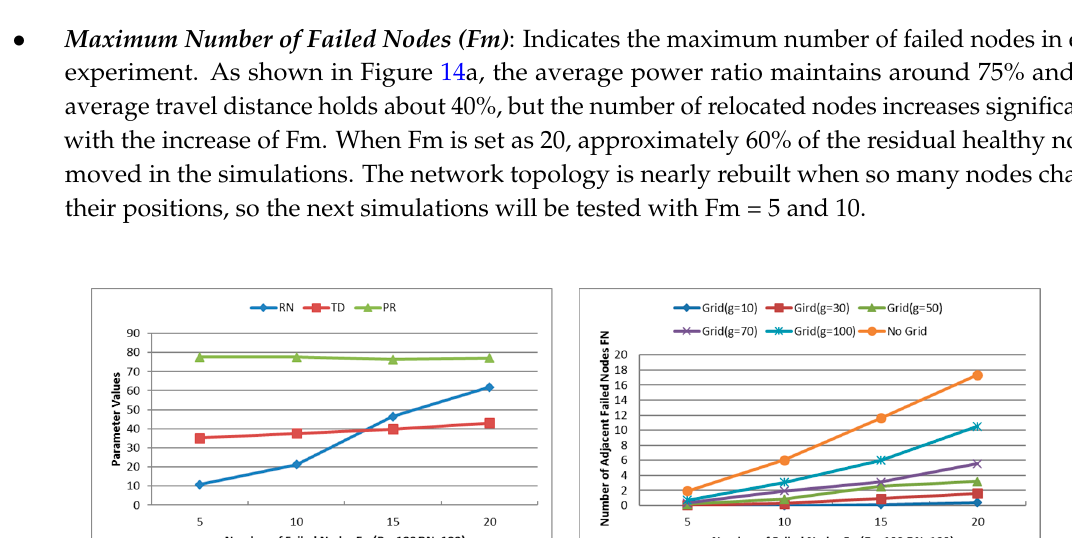
( b ) Figure 15. ( a ) FN with different (cid:1844) (cid:3030) and Fm; and ( b ) FN with different DN and Fm. Figure 15a indicates that the number of adjacent failed nodes increases significantly without gridding in both cases (i.e., Fm = 5 and 10) when the communication range of each node varies from 30 to 140 m. However, the values of FN with gridding in both cases maintain around some fixed values. Similarly, all values of FN maintain around some fixed values in both cases, as can be seen in Figure 15b. Deliberating the results of these simulations, the values of FN are found to have smaller fluctuations with the smaller grid size (cid:1859) when other parameters are the same. Thus, we can image how small the values of FN could be when the grid size (cid:1859) is set under 50. However, as we can see from the simulation results, the value of FN is less than or equal to 1 when the grid size (cid:1859) = 50 with different (cid:1844) (cid:3030) and DN. Moreover, when the grid size is excessively small, too many empty grids that do not contain any nodes will cause unnecessary troubles during the recovery process. Certainly, the computation due to gridding will be more complex when the grid size is excessively small. Hence, the grid size (cid:1859) will be set as 50 m in the following simulations after considering the previous analysis comprehensively and cautiously. 6.2.1. Number of Relocated Nodes (RN) As mentioned before, the number of relocated nodes RN is the primary concern of the node failure restoration with node mobility. While the network is deployed with a fixed number of nodes (DN = 100), the number of relocated nodes increases about 10% when Fm is 5, but that of Fm = 10 increases much more obviously. However, when the communication range (cid:1844) (cid:3030) is set as 100, RN grows fleetly with various DN in both scenarios. Figure 16a,b indicates that when the number of failed nodes increases, the number of relocated nodes grows greatly in dense networks. Again, since